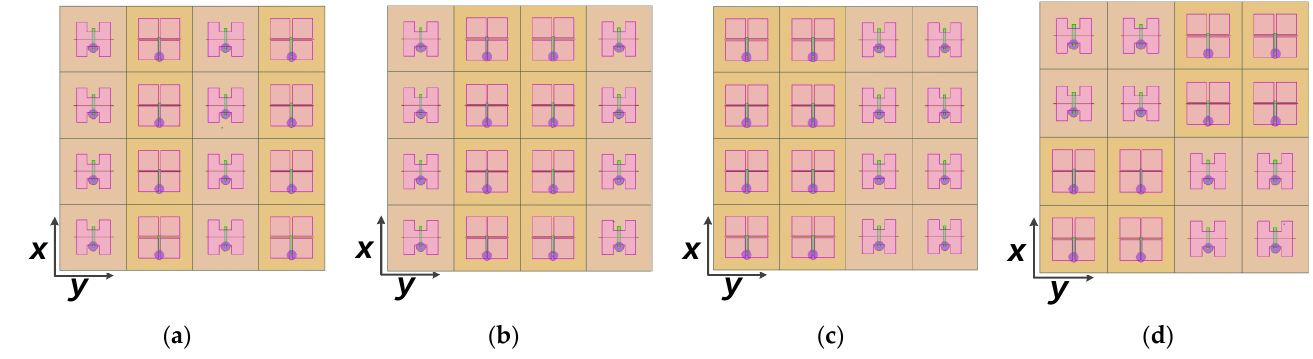
Figure 17. Four forms of proposed arrays. ( a ) ABAB; ( b ) ABBA; ( c ) AABB; ( d ) checkerboard.